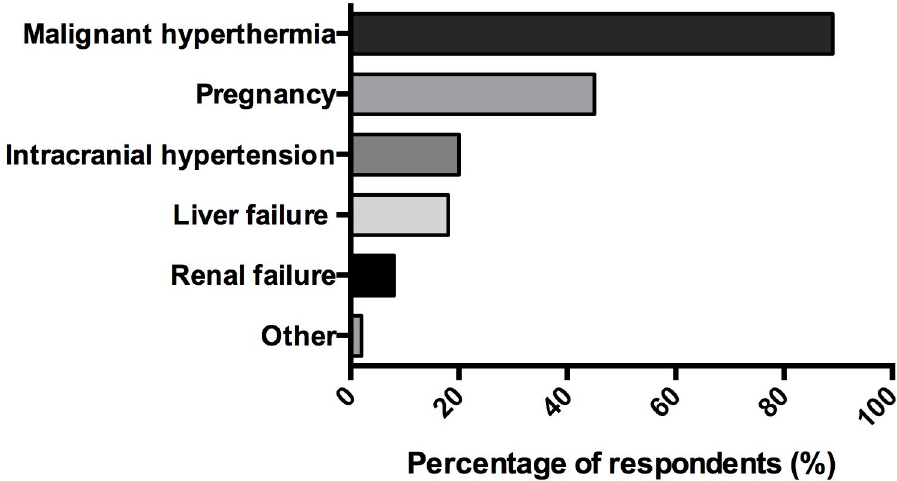
Fig 5. Contraindication of volatile anesthetics for intensive care sedation, as reported by users. (n = 99) Data are represented in % . Overall satisfaction with the use of inhaled sedation among the users is represented in Fig